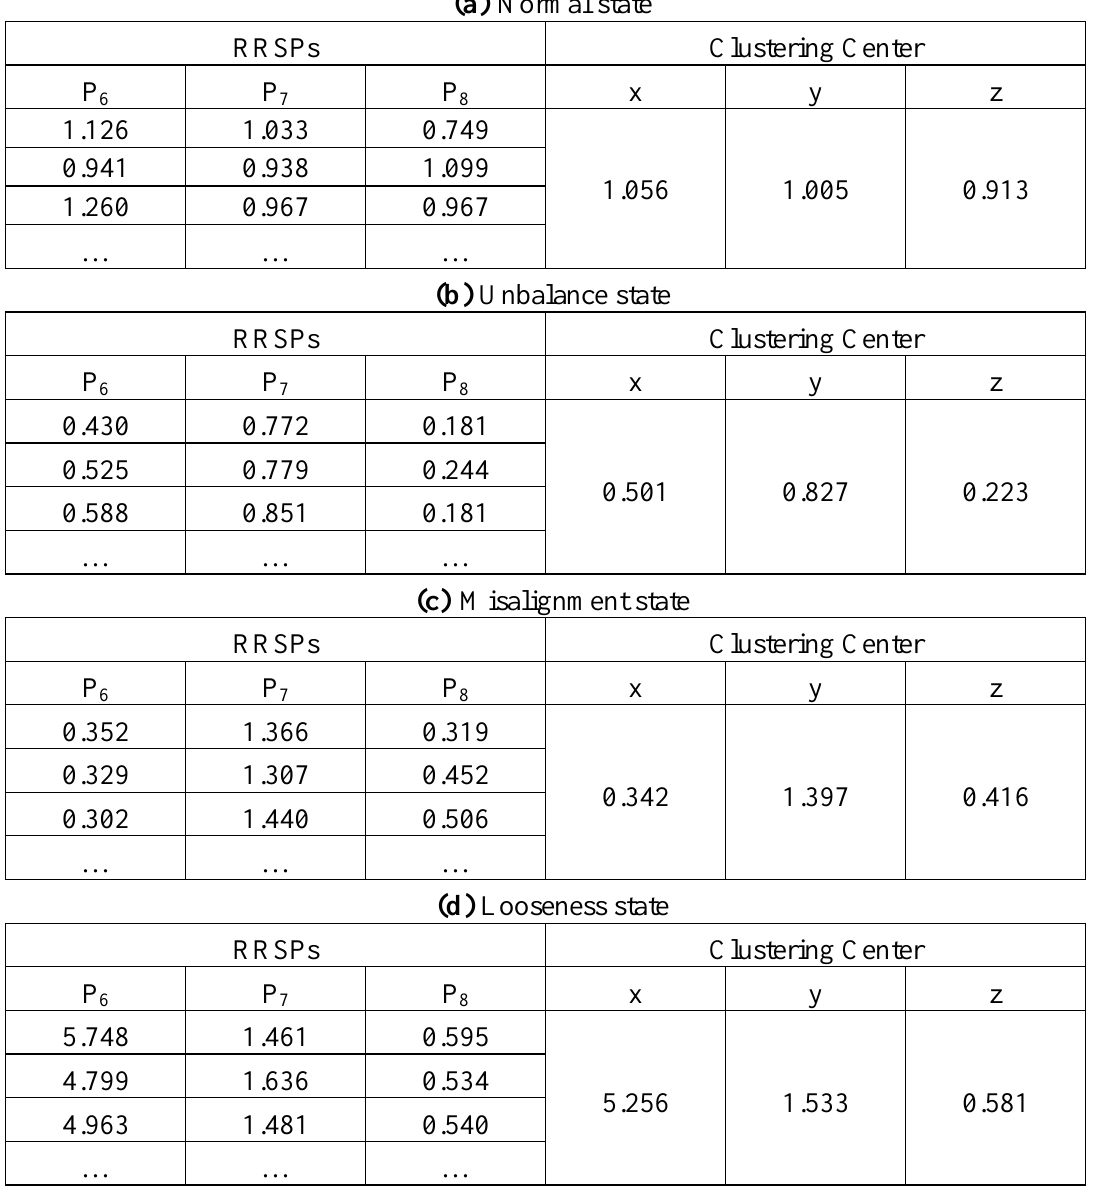
Table 4. Parts of acquired data of diagnosis for the ACO. (a) Normal state, (b) Unbalance state, (c) Misalignment state, (d) Looseness